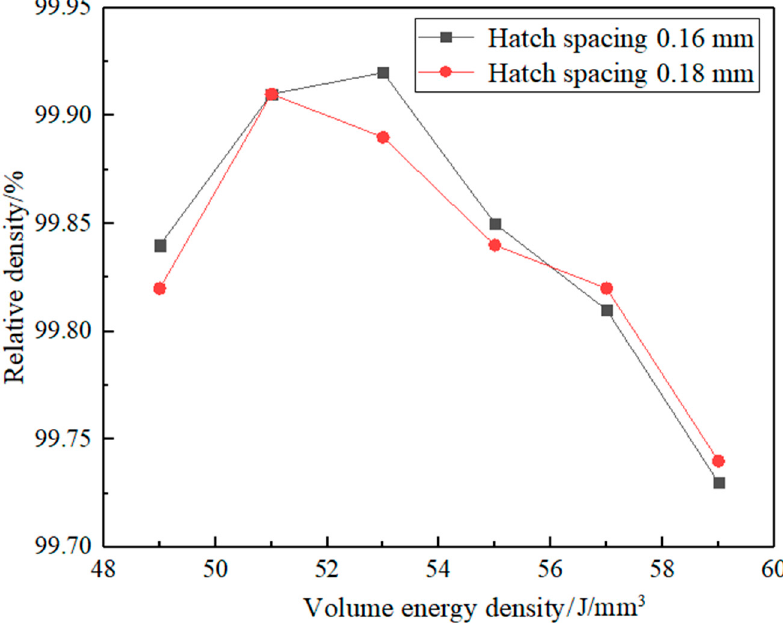
Figure 7. Relative density of AlSi10Mg fabricated with hatch spacing of 0.16 and 0.18 mm, and at different volume energy density/scanning speeds.